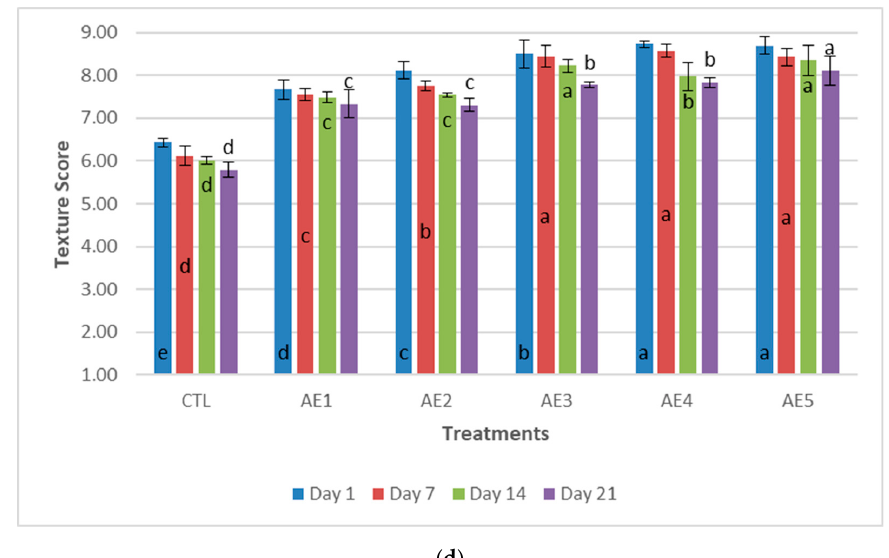
Figure 4. Sensory characteristics ( a ): taste attribute ( b ): flavor attribute ( c ): color attribute ( d ): texture attribute of probiotic yoghurt with addition of APPE. a,b,c,d,e Means in a column of same color with different superscripts were significantly different ( p ≤ 0.05); CTL: Without APPE; AE 1 : 1% APPE; AE 2 : 2% APPE; AE 3 : 3% APPE; AE 4 : 4% APPE; AE 5 : 5% APPE.